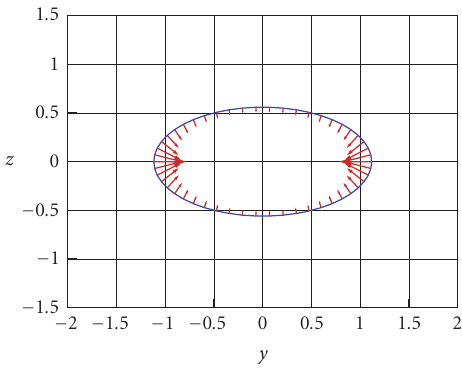
Figure 6.4. Normal stress ( T nn n y + T nn n z ) / 150dyn/cm 2 for an ellipse y 2 /b 2 + z 2 /c 2 = 1 − 2 . 0 2 /a 2 at x = − 2 . 0 cm in the ( y , z )-plane. Perpendicular view of the cross section (c) in Figure 6.1. Strong com- pression at the right and left poles of the ellipse and mild compression towards the center.